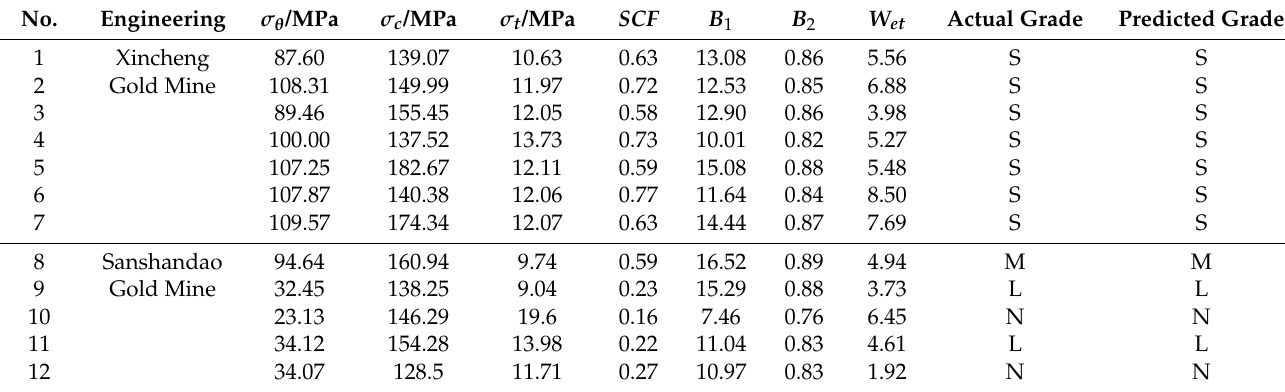
Table 15. Application of DF model in practical